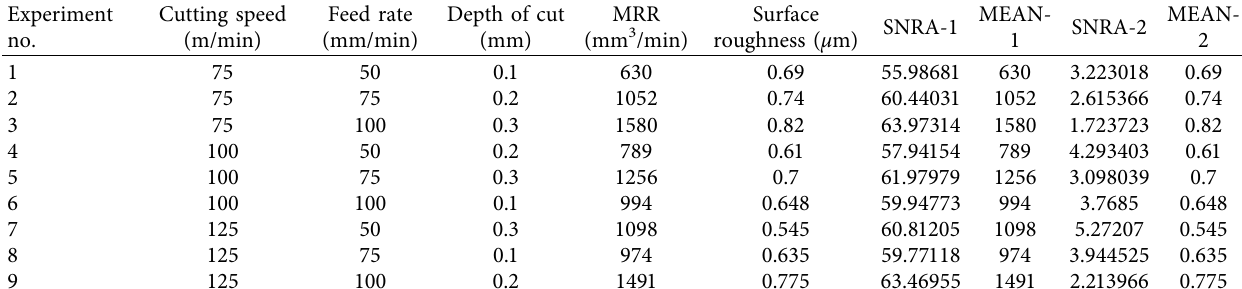
Table 4: Orthogonal array ( L 9 ) and its output responses for the end milling